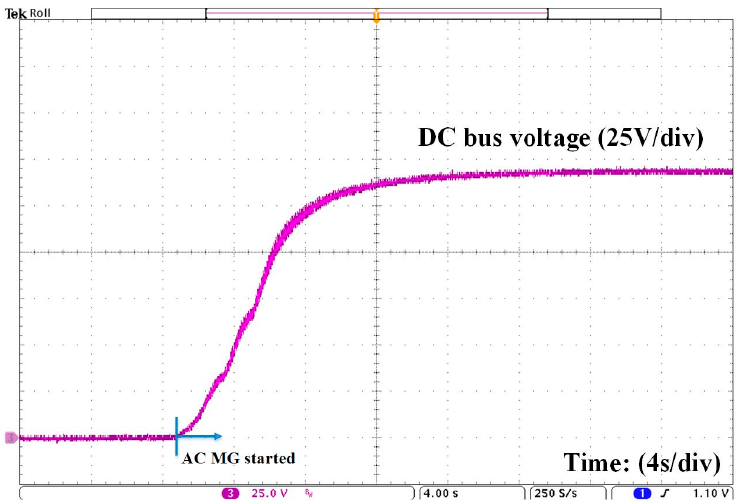
Figure 23. Connection to the main grid (MG).